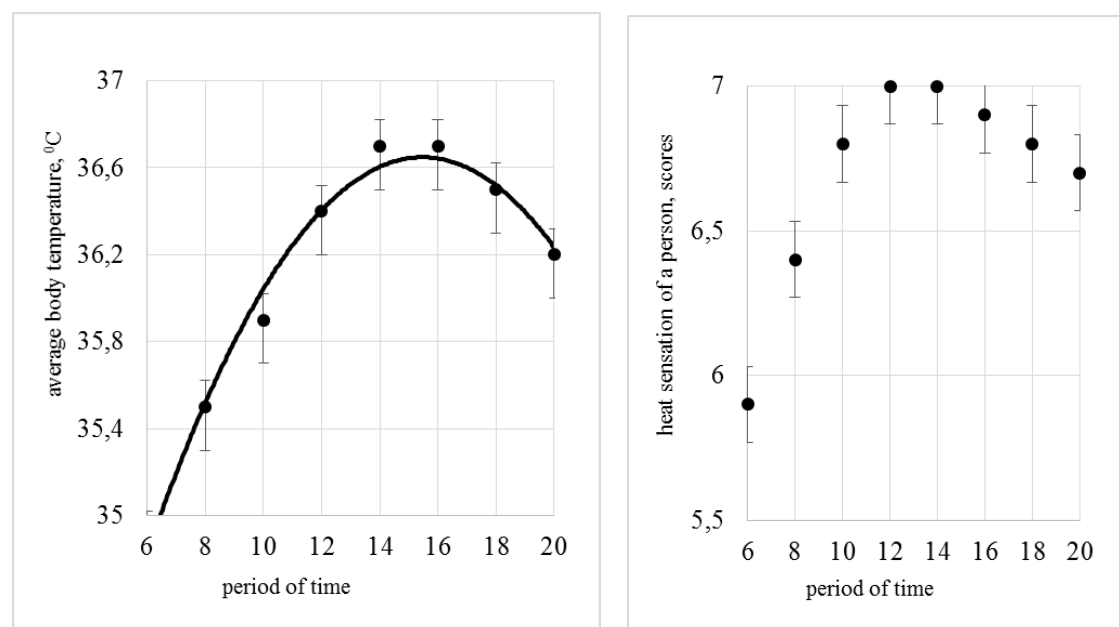
Fig. 4. Change in average body temperature and heat sensation during the day in the driver’s cab of route bus in summer.